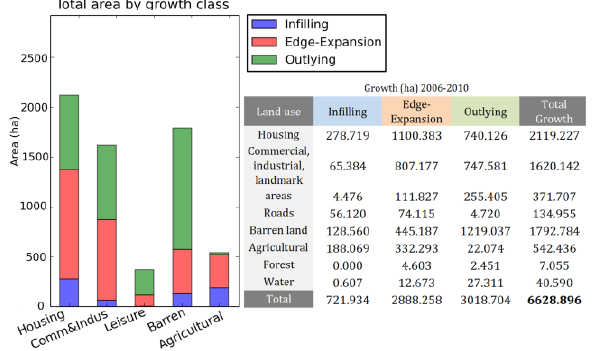
Figure 7. Total area of different types of growth by class in the area of